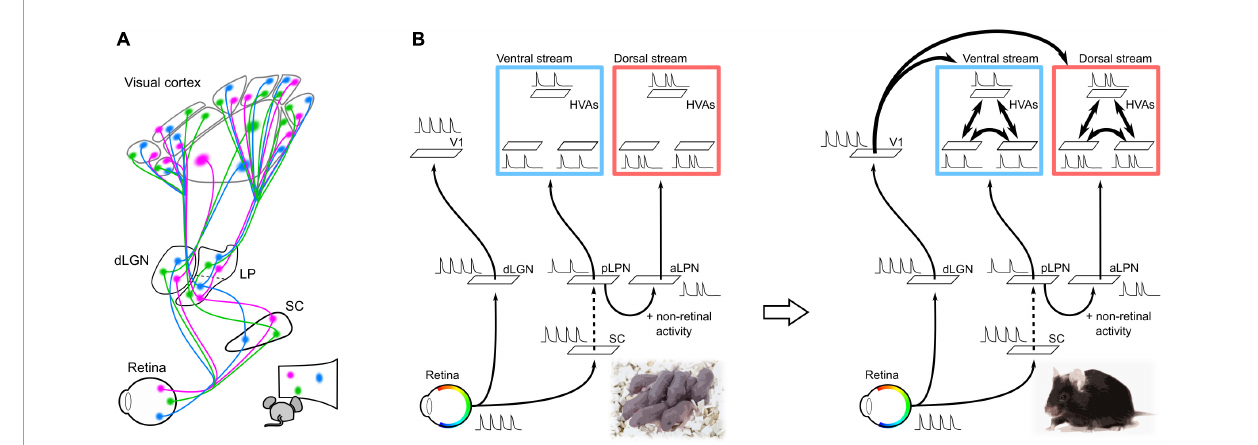
FIGURE2 Neural pathways and spontaneous retinal activity propagation in the developing mouse brain. (A) Schematic of the visual neural network at P5. V1 and HVAs receive retinal activity along parallel pathways from the retina via the dLGN or LPN in the developing mouse brain at P5 (parallel module structure). Spontaneous retinal activity contains retinotopic information, which allows all visual areas to obtain retinotopic maps before the formation of corticocortical connections. (B) Hypothesis of the propagation of retinal activity at P5. The spontaneous activities of V1 and HVA at P5 were not perfectly synchronized, even though they were of retinal origin. This suggests that spontaneous retinal activity underwent some decorrelation before propagating to the cortex. The retina–dLGN–V1, retina–SC, and LPN-HVA pathways likely propagate spontaneous activity with high transfer efficiency. Conversely, projections from the SC to the LPN may have a low transfer efficiency and cause a drop in retinal activity. In addition to the transfer efficiency, there is a difference in spontaneous activity between HVAs in the dorsal and ventral pathways, which may be due to the addition of non-retinal derived activity in the